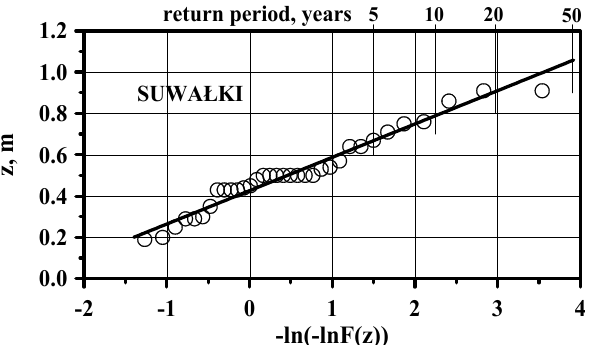
Figure 6. Maximum depth of zero centigrade temperature presented on the Gumbel probability plot. Reprint with permission [31]; Copyright 2017, Building Research Institute.